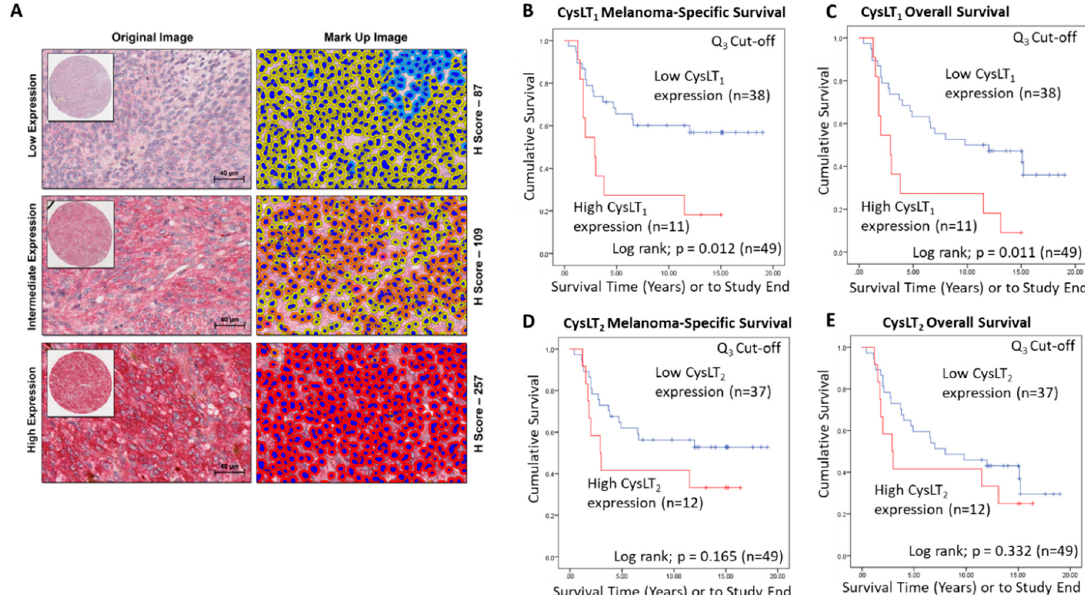
Figure 3. Examination of the prognostic value of CysLT 1 and CysLT 2 protein expression in primary UM patient samples by digital pathology analysis. ( A ) Representative cores from the UM TMA designated with a score of Low, Intermediate, or High expression for CysLT 1 staining following digital analysis (Scale = 40 µ m). ( B ) High expression of CysLT 1 (red) is associated with reduced survival from metastatic melanoma in primary UM patients ( n = 49; Log-rank; p = 0.012; HR 2.755; 95% CI 1.205–6.3) ( C ) High expression of CysLT 1 (red) is associated with reduced overall survival in primary UM patients ( n = 49; Log-rank; p = 0.011; HR 2.755; 95% CI 1.205–6.3) ( D ) Kaplan–Meier survival curve stratified based by high (red) or low (blue) CysLT 2 expression and death by metastatic melanoma ( n = 49; Log-rank; p = 0.165; HR 1.796; 95% CI 0.773–4.172). ( E ) Kaplan–Meier survival curve stratified based by high (red) or low (blue) CysLT 2 expression and death by any cause ( n = 50; Log-rank; p = 0.332; HR 1.461; 95% CI 0.674–3.167). The third quartile was used as the cut-o ff point for high versus low expression for all Kaplan–Meier survival curves. Number of events indicates the number of deaths due to metastatic melanoma ( B , D ). Number of events indicates the number of deaths due to any cause ( C , E ).